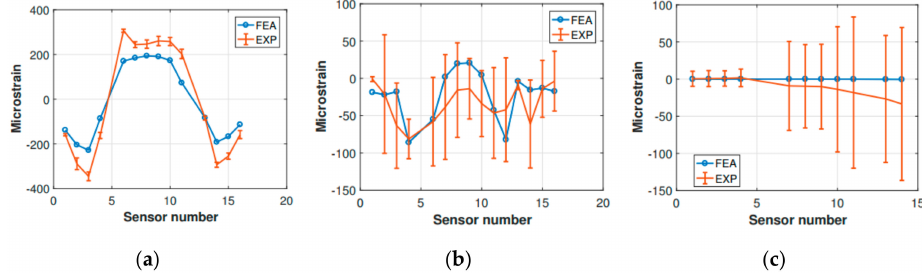
Figure 12. Experimental (EXP) vs. finite element analysis (FEA) strain comparison for ( a ) frame 7, ( b ) frame 10, and ( c ) tail